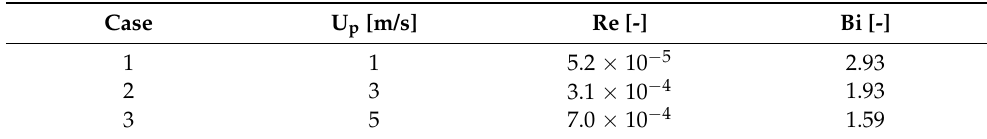
Table 1. Flow conditions and the associated dimensionless numbers.